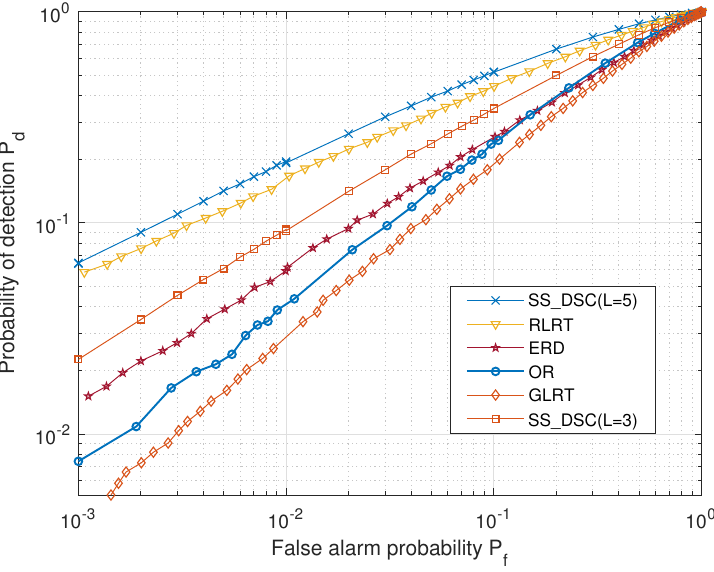
Figure 9. ROC curves of the five different algorithms where γ = –10 dB and Num = 20 .